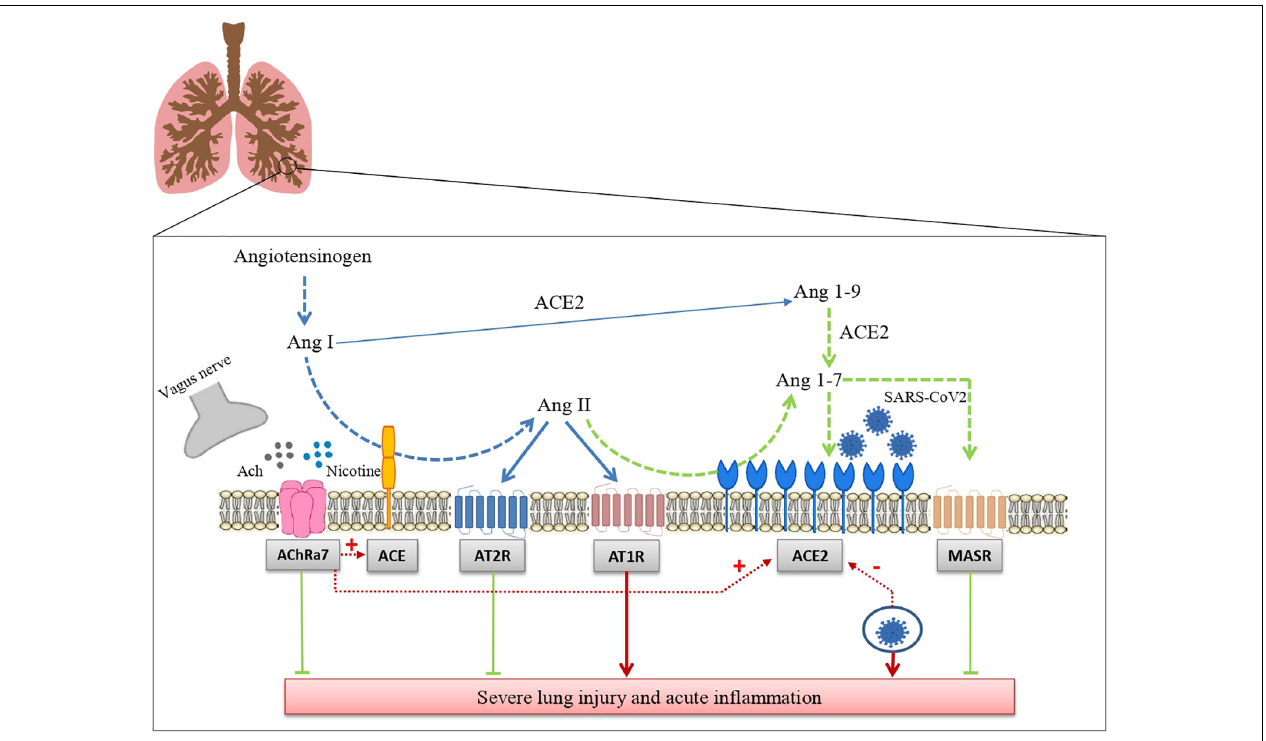
FIGURE 1 | Interaction between the renin angiotensin system and the cholinergic anti-inflammatory pathway in SARS-CoV-2 lung infection. The drawing shows how the renin angiotensin system and the cholinergic anti-inflammatory pathway modulate tissue inflammation in lungs infected with SARS-CoV-2 and how these two systems interact with each other (see the text for further details). Ang I: Angiotensin I; Ang II: angiotensin II; Ang-(1–7): angiotensin 1-7; Ang-(1–9): angiotensin 1-9; ACE: angiotensin-converting enzyme; ACE2: Angiotensin-converting enzyme 2; AT1R: Angiotensin Receptor 1; AT2: Angiotensin Receptor 2; MASR: Mas